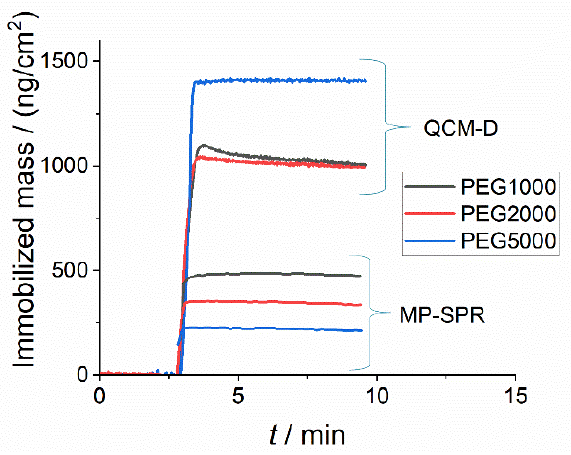
Figure 1. Immobilized lipodisk (80 moL% DSPC and 20 moL% DSPE-PEG lipids) mass density on silica surfaces as determined using QCM-D (i.e., wet mass) and MP-SPR (dry mass) for several lengths of the PEG-lipid. T = 21 °C.